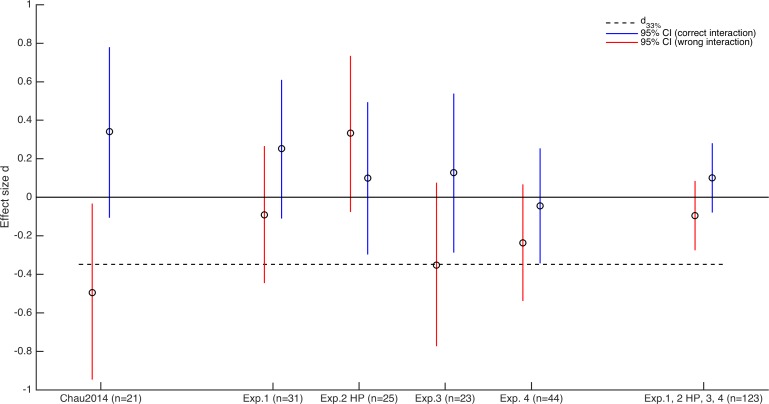
Effect sizes and test of detectability.Depicted are the effect sizes and their 95% and 90% CIs of the HV-D effect on relative choice accuracy for the Chau2014 dataset, for Experiment 1, 2 (Group HP), 3, and 4, and for all four experiments combined, separately for analysis with correct (blue) and incorrect (red) implementation of the interaction term (see Materials and methods). The black dashed line indicates the d33% effect size (i.e., the effect size at which the Chau2014 study with 21 participants would have only 33% statistical power to detect an effect). According to Simonsohn (2015), if the CIs of the effect size in the replication study do not overlap with d33%, then it is unlikely that such an effect was detectable with the original sample size. Note that the HV-D effects are generally lower when using the incorrect interaction term (except for Experiment 2 HP). But even in this case, the data would be best explained as a null finding.